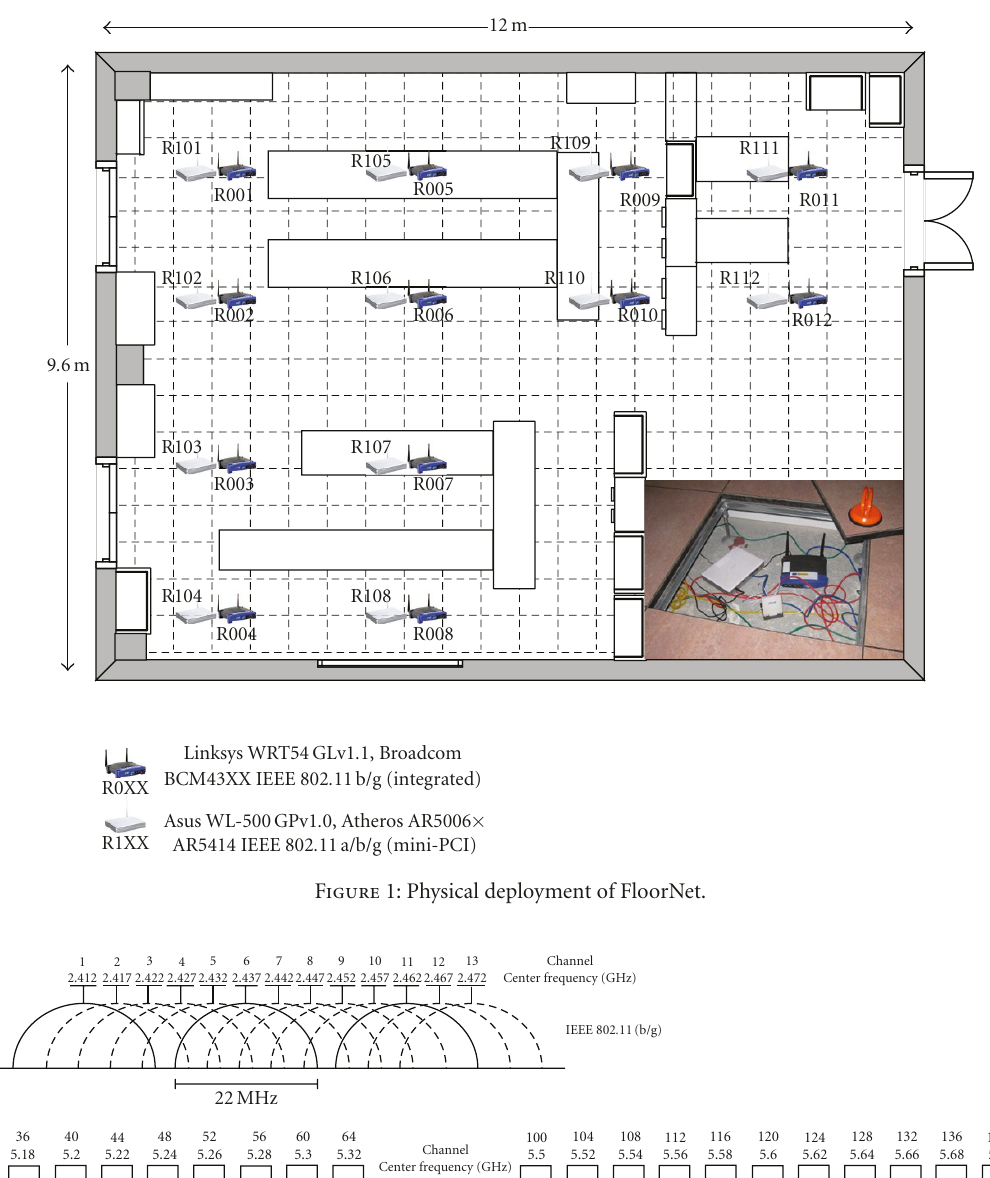
Figure 2: Available 802.11g and 802.11a channels in